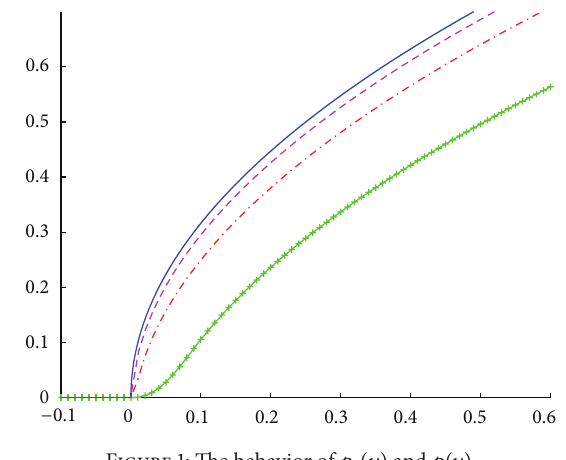
Figure 1: The behavior of 𝑝 𝜖 (𝑢) and 𝑝(𝑢)